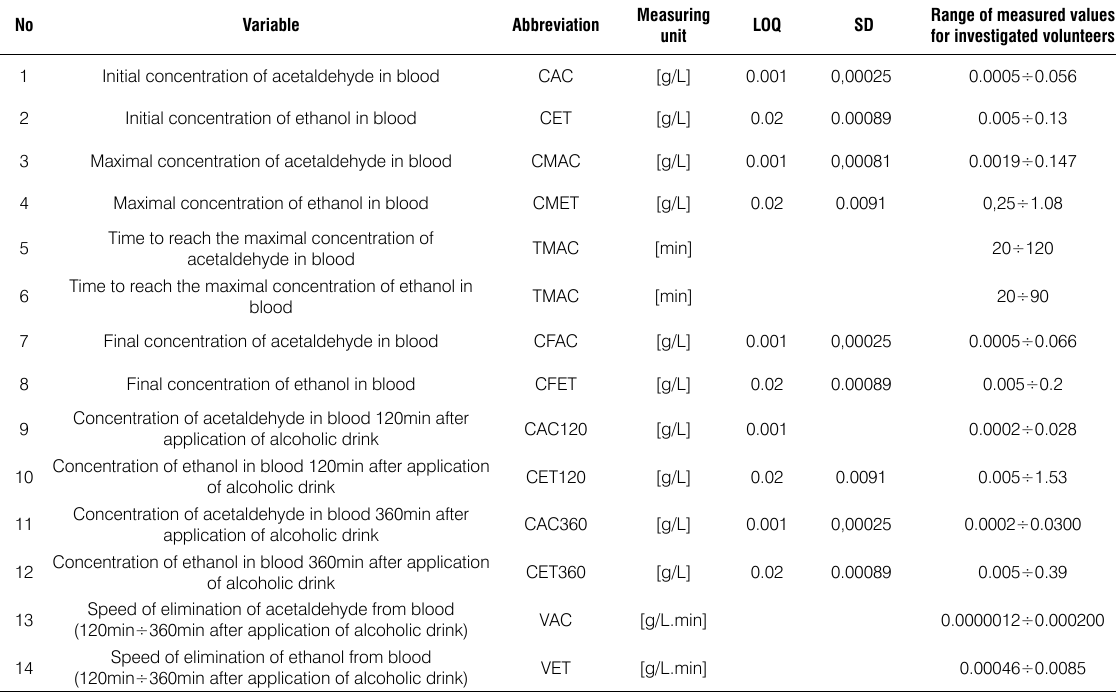
Table 1. Kinetic variables with their units, limit of quantitation, standard deviation and range of measured values.